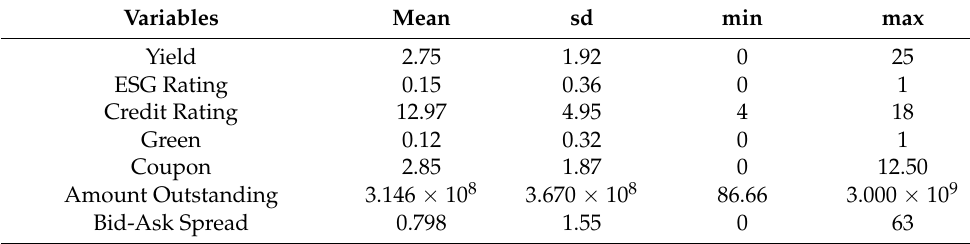
Table 3. Descriptive statistics of explanatory